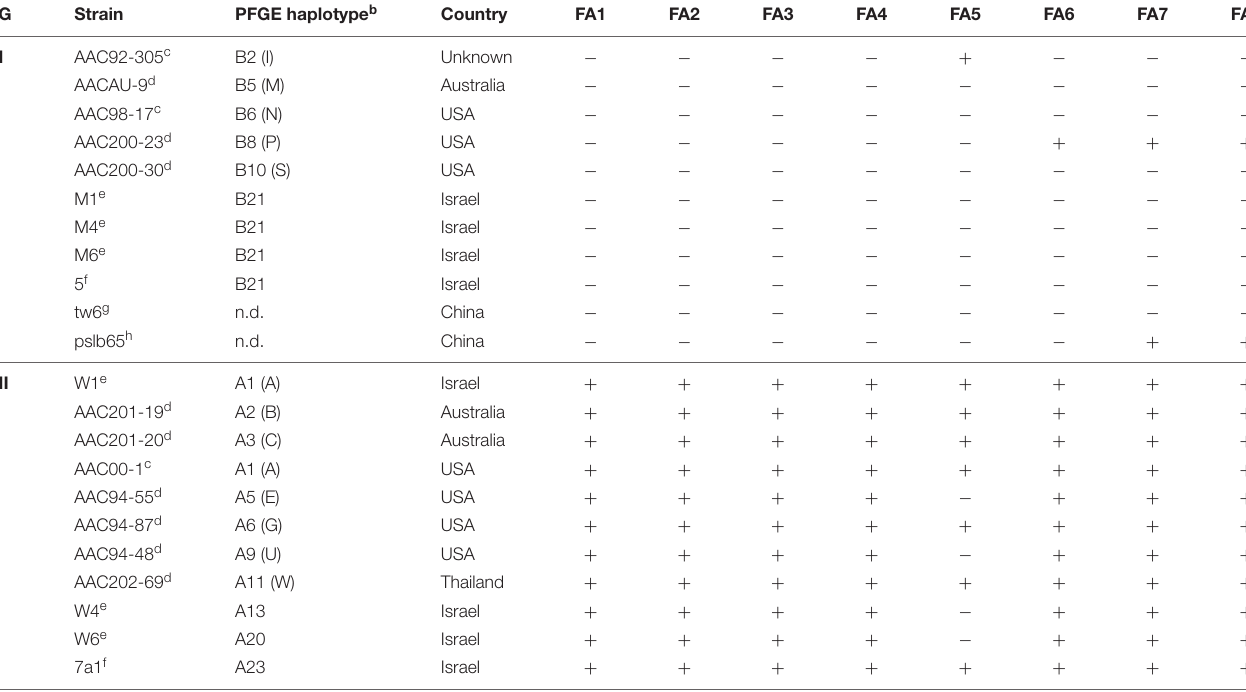
TABLE 2 | Acidovorax citrulli strains tested by PCR analysis with sets of primers targeting regions from the AAC00-1 FA fragments a . G Strain